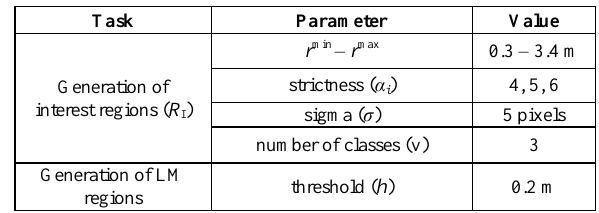
Table 1. Parameters of the proposed